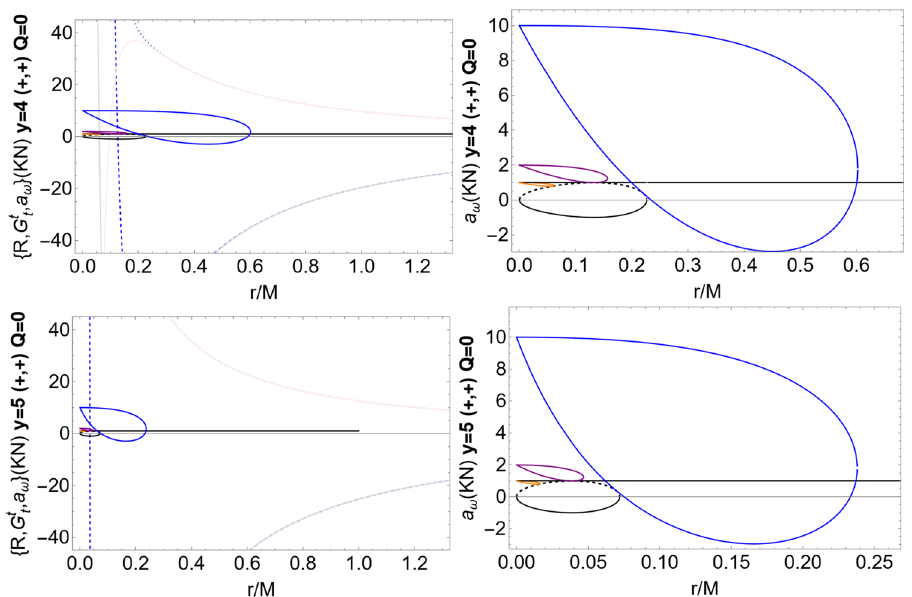
Fig. 27 Deformation of the Kerr geometry ( KN geometry with Q = 0), with Kerr reference metric in Boyer–Lindquist coordinates (met- ric signature ( − , + , + , + ) ) on the equatorial plane, where M = 1. Metric bundle a ω , Ricci curvature scalar R and Einstein tensor com- ponent G t t are plotted for different deformation parameters { ( b , f ), y } , where { blue , purple , orange , bro w n } curves refer to bundles char-